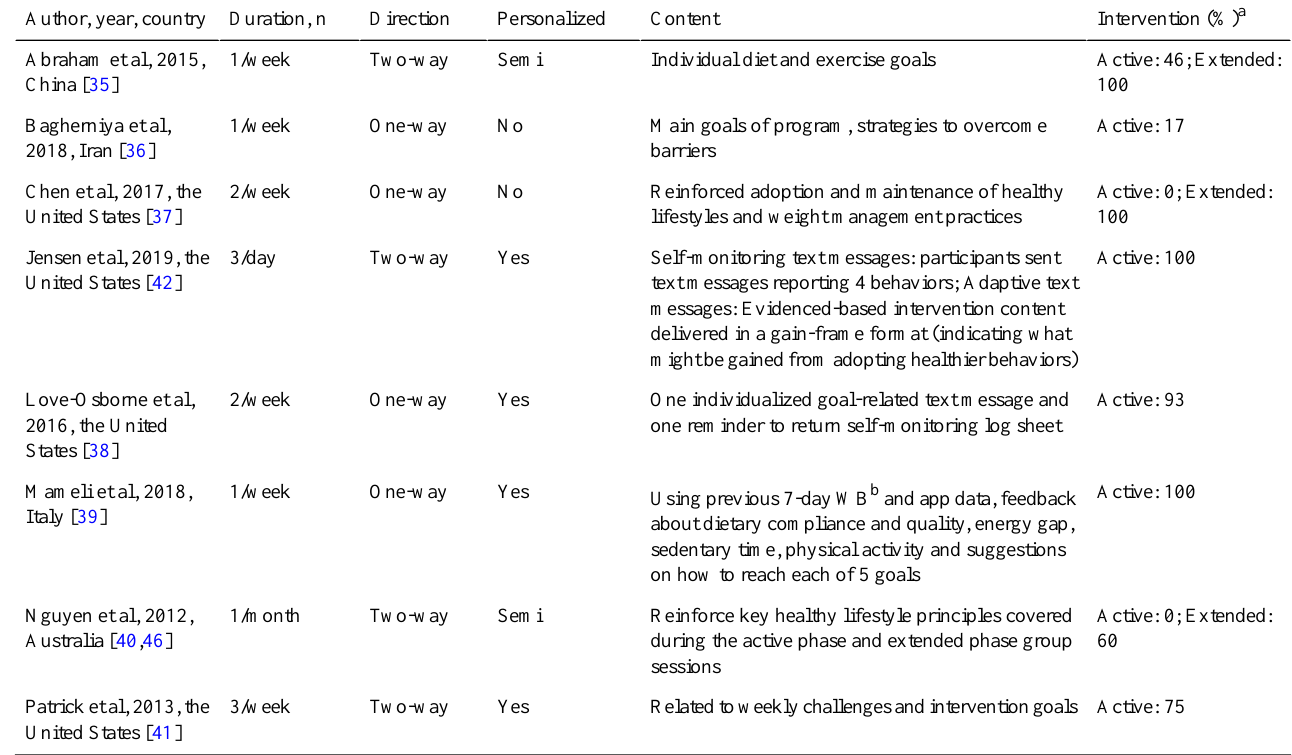
Table 7. Text message details of included studies